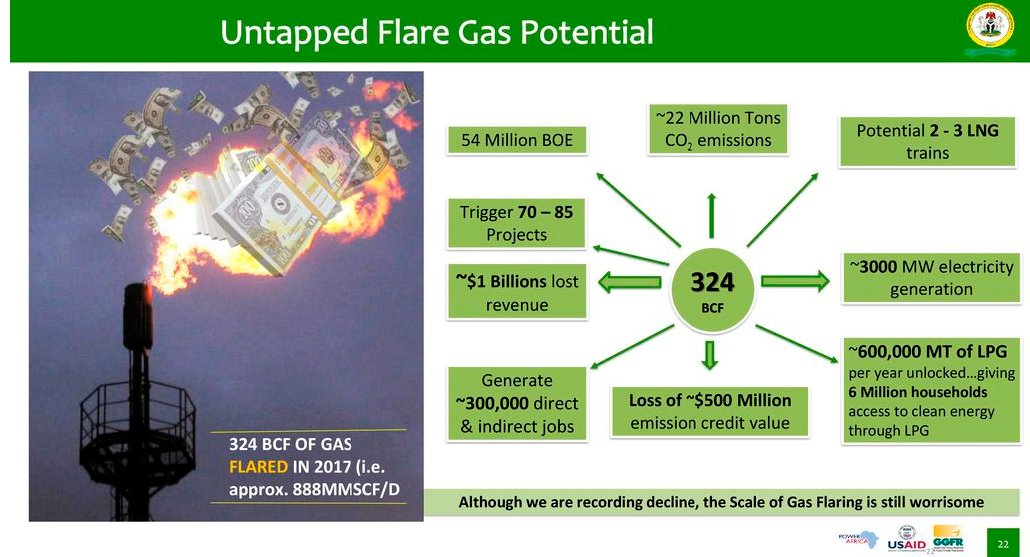
Figure 3. Untapped Flared Gas Resources in Nigeria. Sources: Nigerian Gas Flare Commercialization Programme, available at : http://www.ngfcp.gov.ng/about-us/our-mandate/our- strategy/ (accessed 16 September 2019). Define BOE.